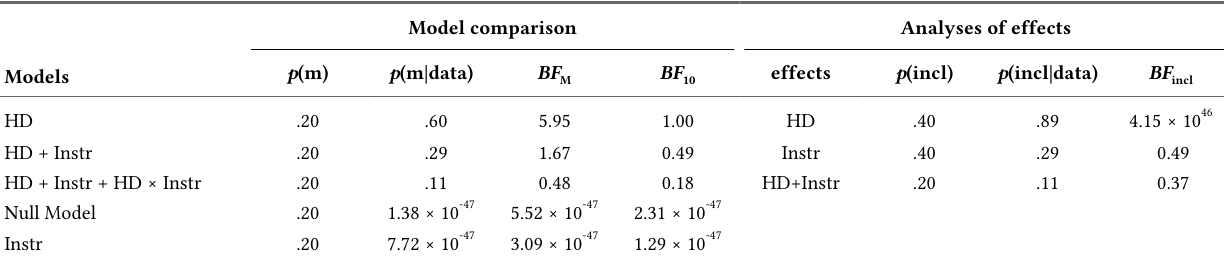
Results of the Bayesian Mixed Design ANOVA With the Within-Subject Factor Hundred Distance and Between-Subject Factor Instruction